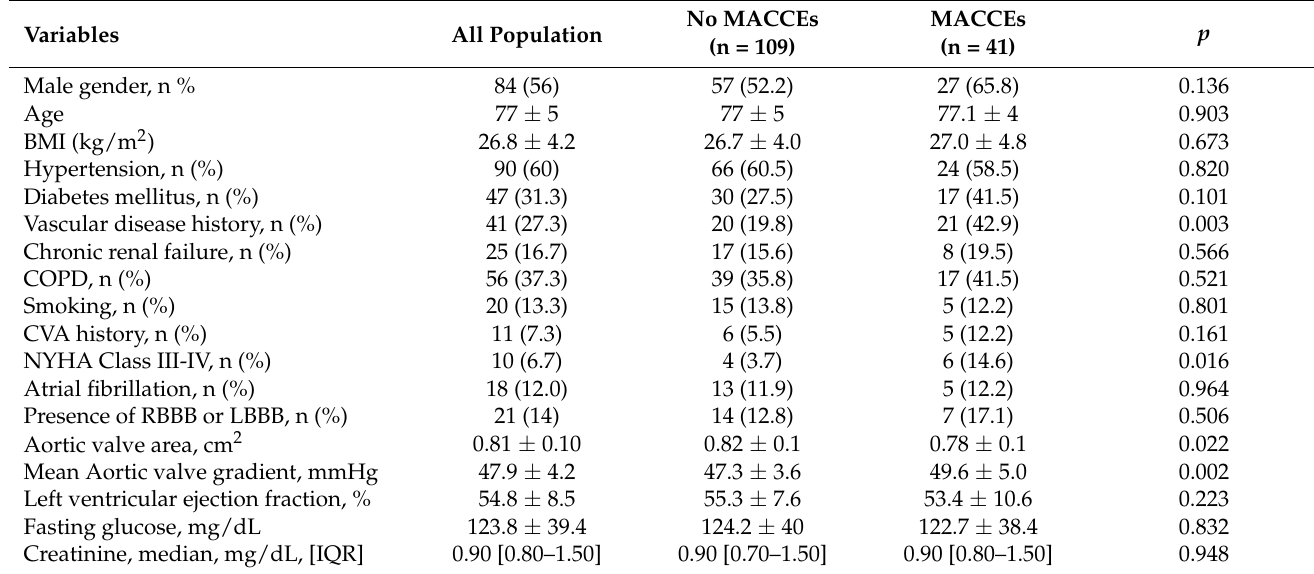
Table 1. Baseline demographic, clinical and laboratory parameters of the study cohort grouped according to the presence of